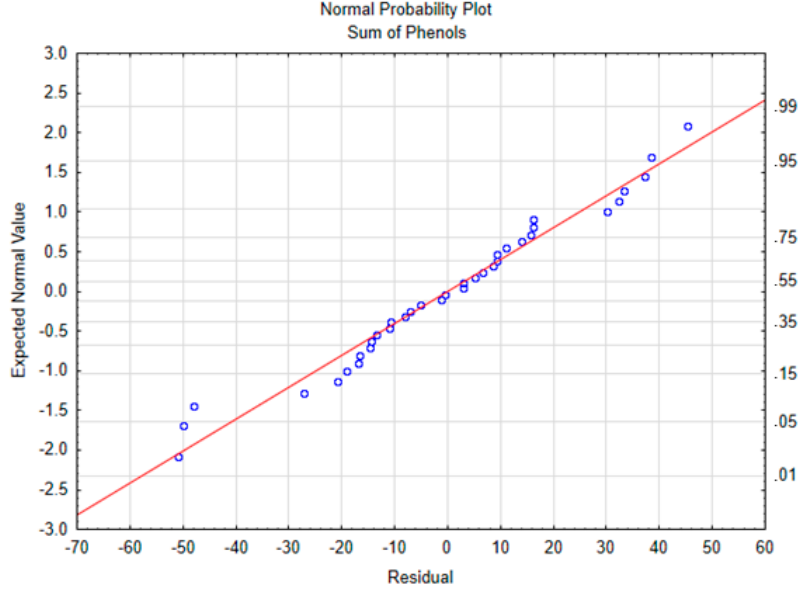
Figure 1. Normal probability plot of the sum of phenols.